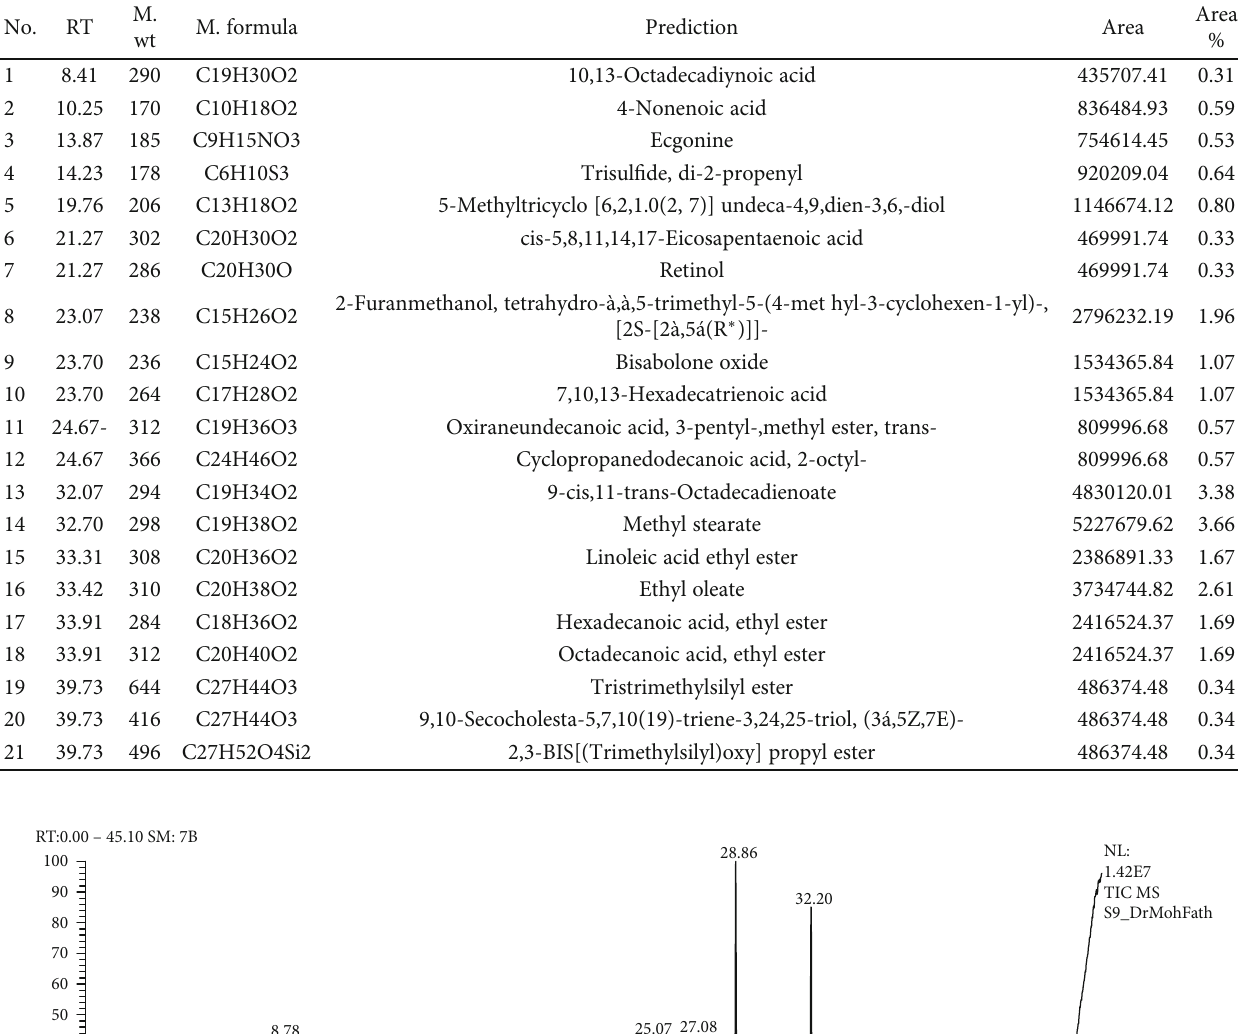
Table 2: Identi fi ed compounds in aqueous extract of Piper nigrum .